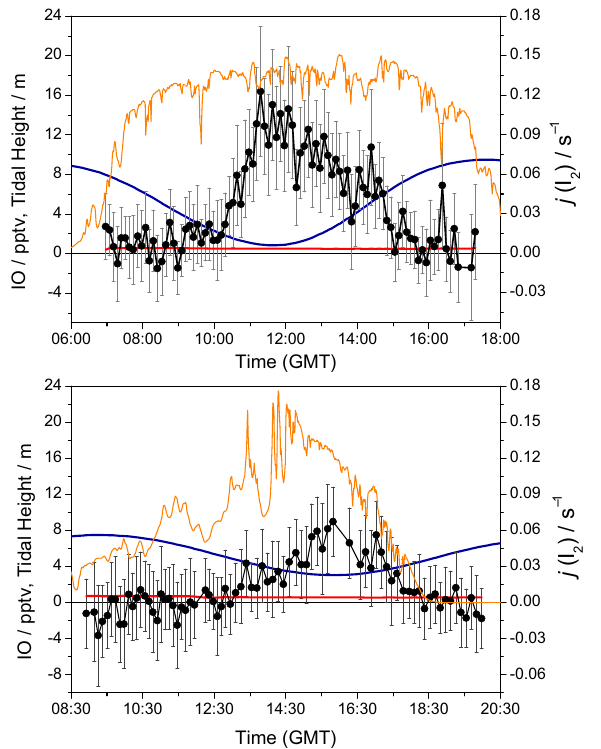
Fig. 6. Daytime IO profiles on 8th September (top) and 14th September (bottom). The black dots represent IO (150 s integration period, error bars represent the 23% 1 σ calibration error combined with the 1% error from the laser power normalisation and the 1 σ precision of the normalised signal), the red line represents the limit of detection (0.8 pptv for 150 s integration period), the orange line represents j (I 2 ) and the blue line represents tidal height. A clear dependence of IO on tidal height is displayed as IO peaked at the tidal minimum. The bottom panel shows that IO peaked at the tidal minimum rather than peak j (I 2 ). The variability of IO in the morning and evening around zero is within one standard deviation of the background signal.